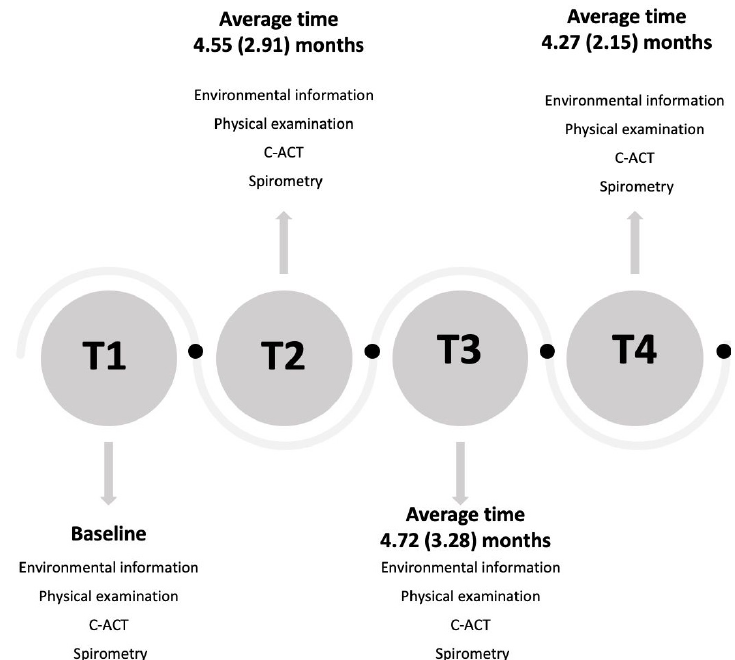
Figure 1. Study Figure 1. Study flowchart.